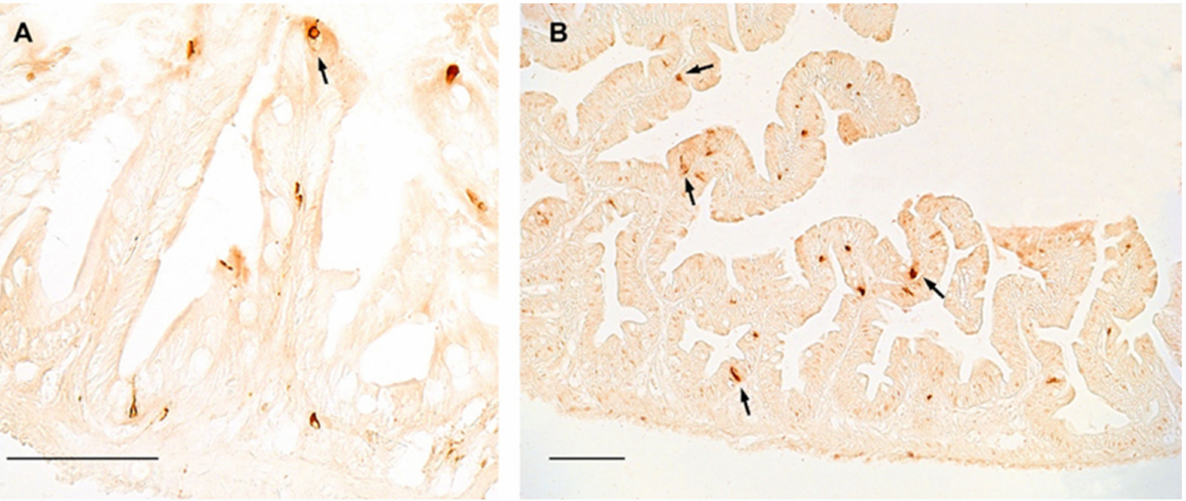
Figure 3. NPY immunoreactivity in the foregut of turquoise killifish. ( A ) Transverse section of the foregut of 5 wph turquoise killifish showing NPY immunopositivity in the cytoplasm of few enteroendocrine cells (arrow). ( B ) Transverse section of the foregut of 27 wph turquoise killifish showing NPY immunopositivity in the cytoplasm of enteroendocrine cells (arrows) over different villi. Similarly, in zebrafish, NPY was distributed in the cytoplasm of clearly identifiable enteroendocrine cells of the foregut of young (Figure 4A) and old (Figure 4B) animals, with a slight increase in the foregut of old specimens. NPY immunostaining was clearly identified in the fibers of the myenteric plexus (Figure 4B), without age-related changes.